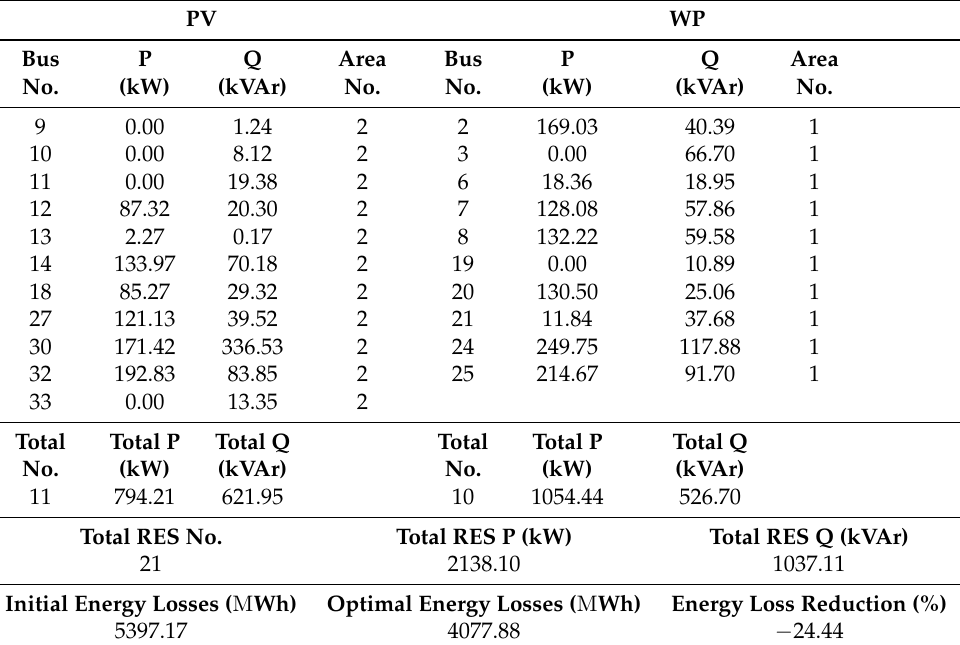
Table 16. Snapshot approach—50% value—Scenario